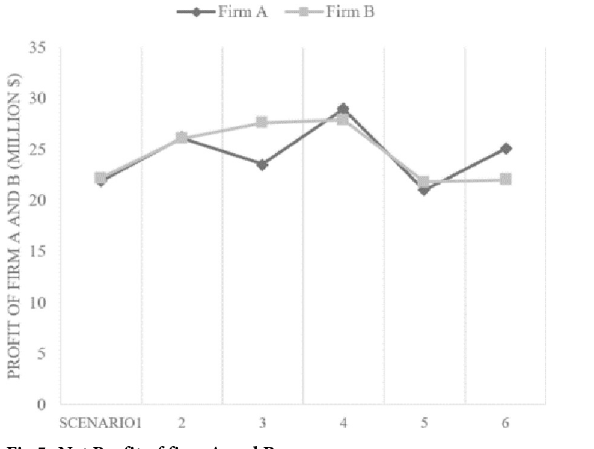
Fig 5. Net Profit of firm A and